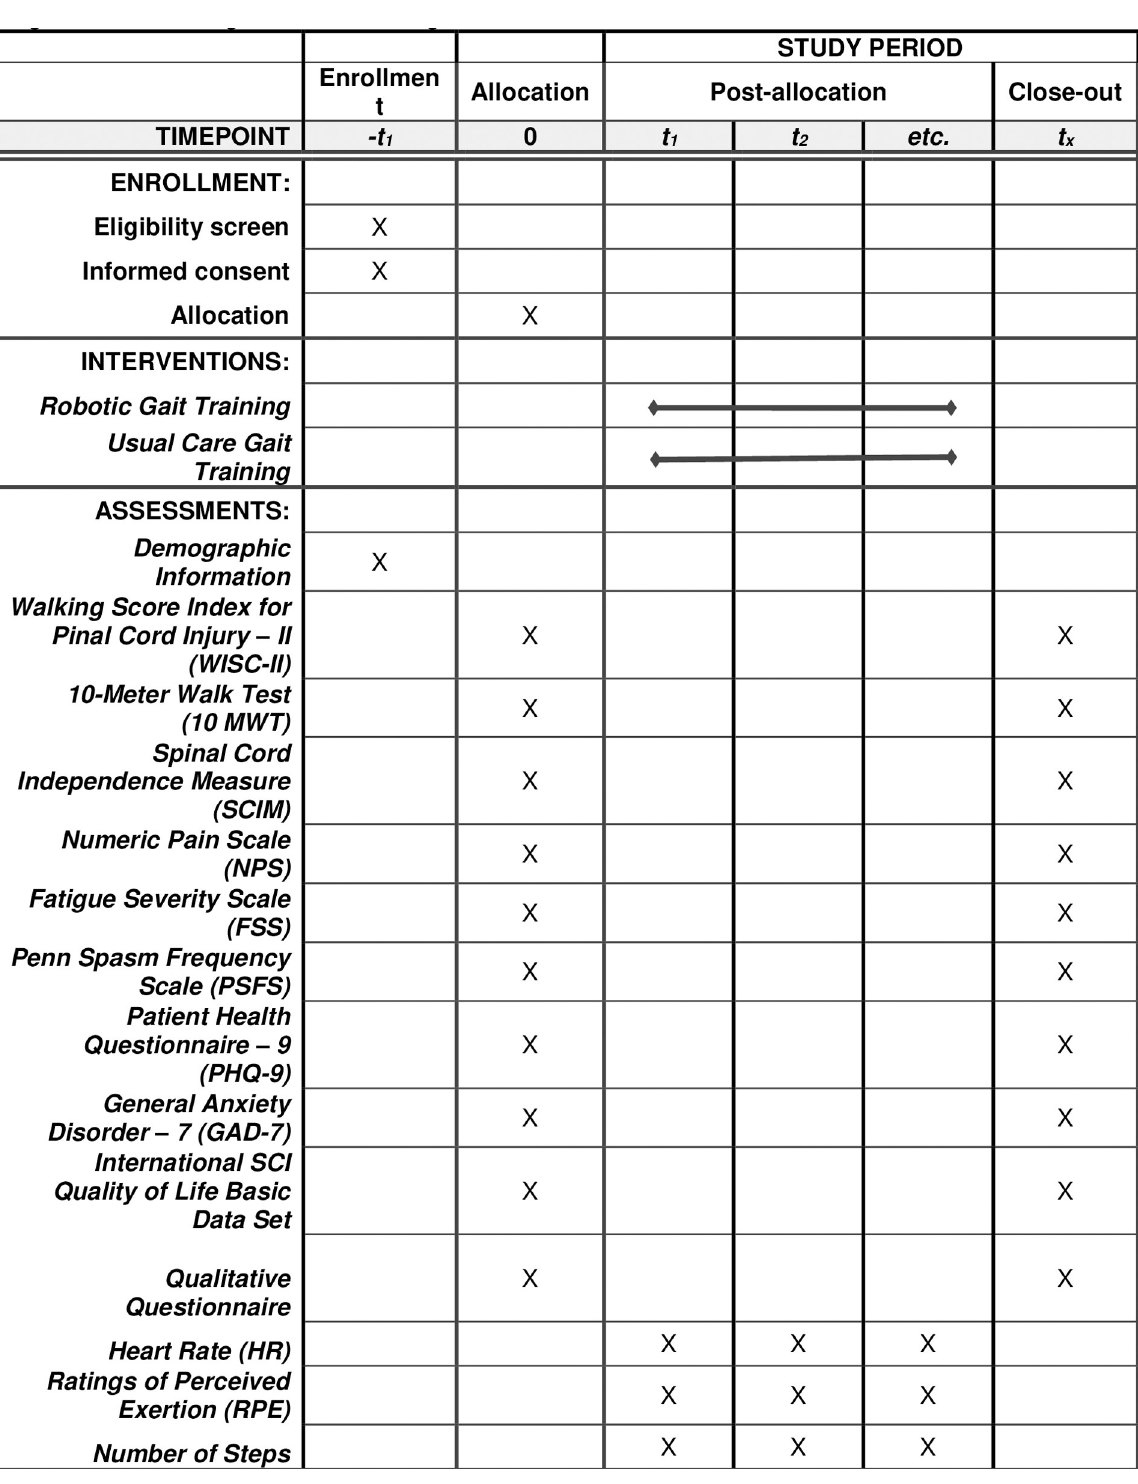
PLOS ONE | https://doi.org/10.1371/journal.pone.0267013 May 10,